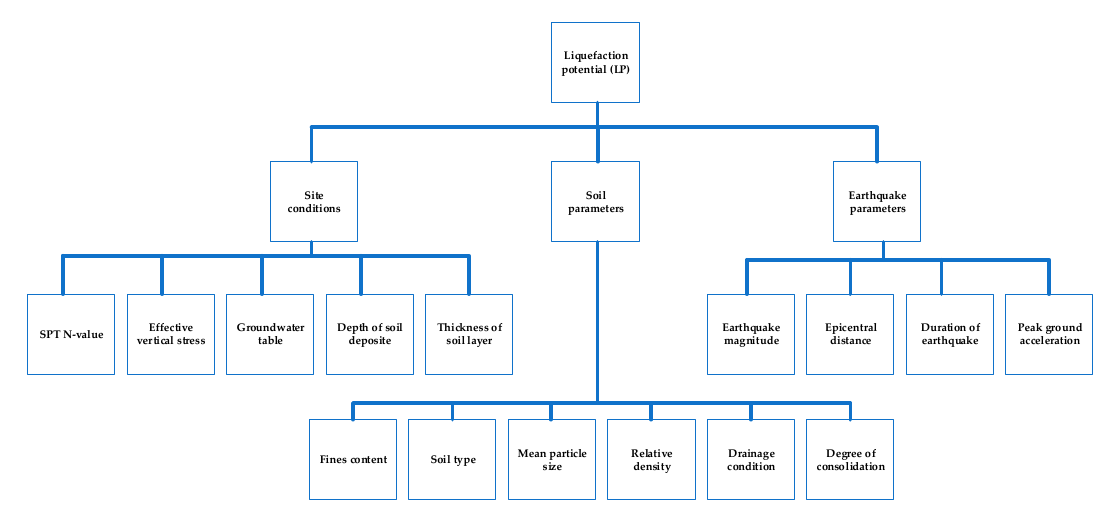
Figure 2. Hierarchy structure for significant factors of seismic soil liquefaction.